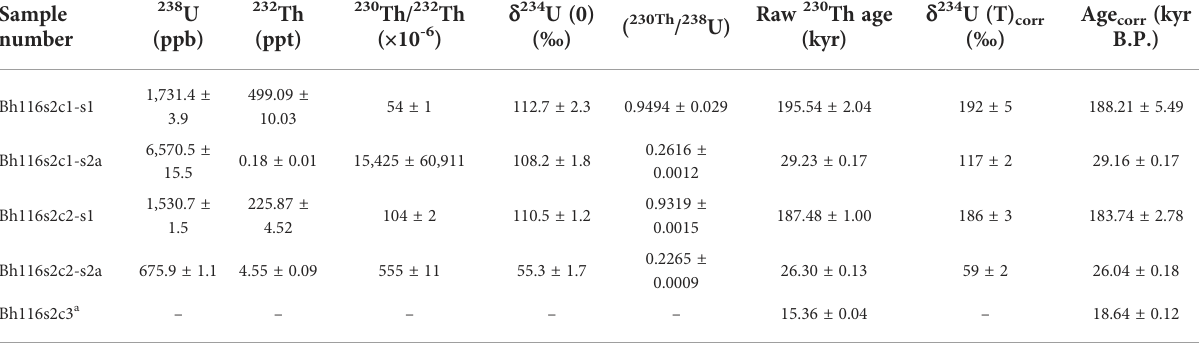
TABLE 1 U-series and radiocarbon ages of sample Bh116 from Sansha Yongle Blue Hole. Sample